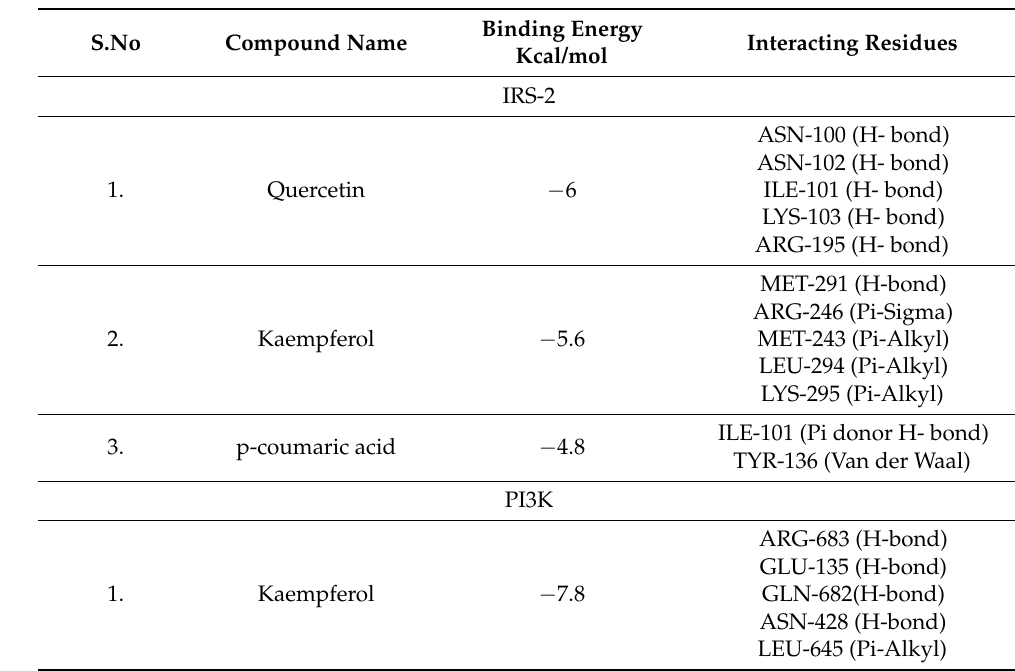
Figure 15. Lead compounds and their interaction with GLUT 2 at the molecular level. ( a ) Quercetin; ( b ) kaempferol; ( c ) caffeic acid; ( d ) p-coumaric acid. Table 3. C. papaya’s top compounds and interactions and results with the target proteins .